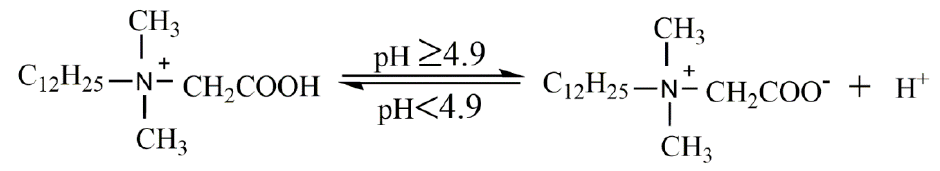
Figure 2. Chemical equilibrium reaction of BS-12 in aqueous solution.